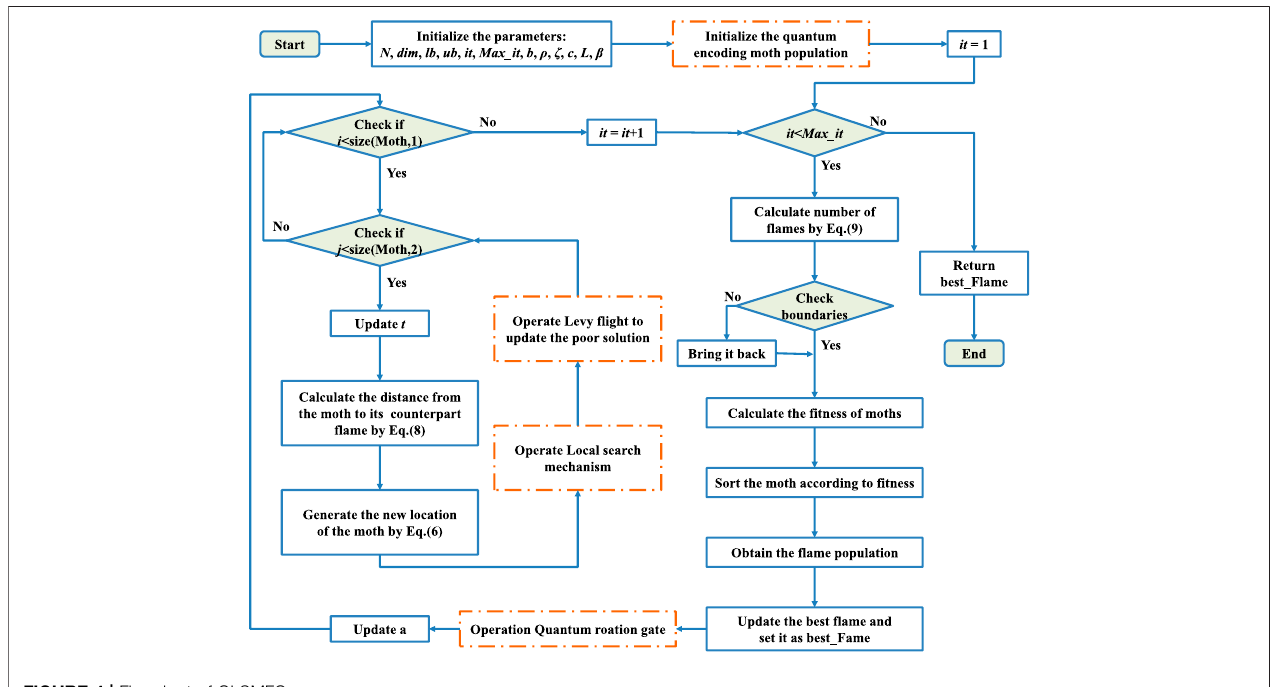
FIGURE 4 | Flowchart of QLSMFO.